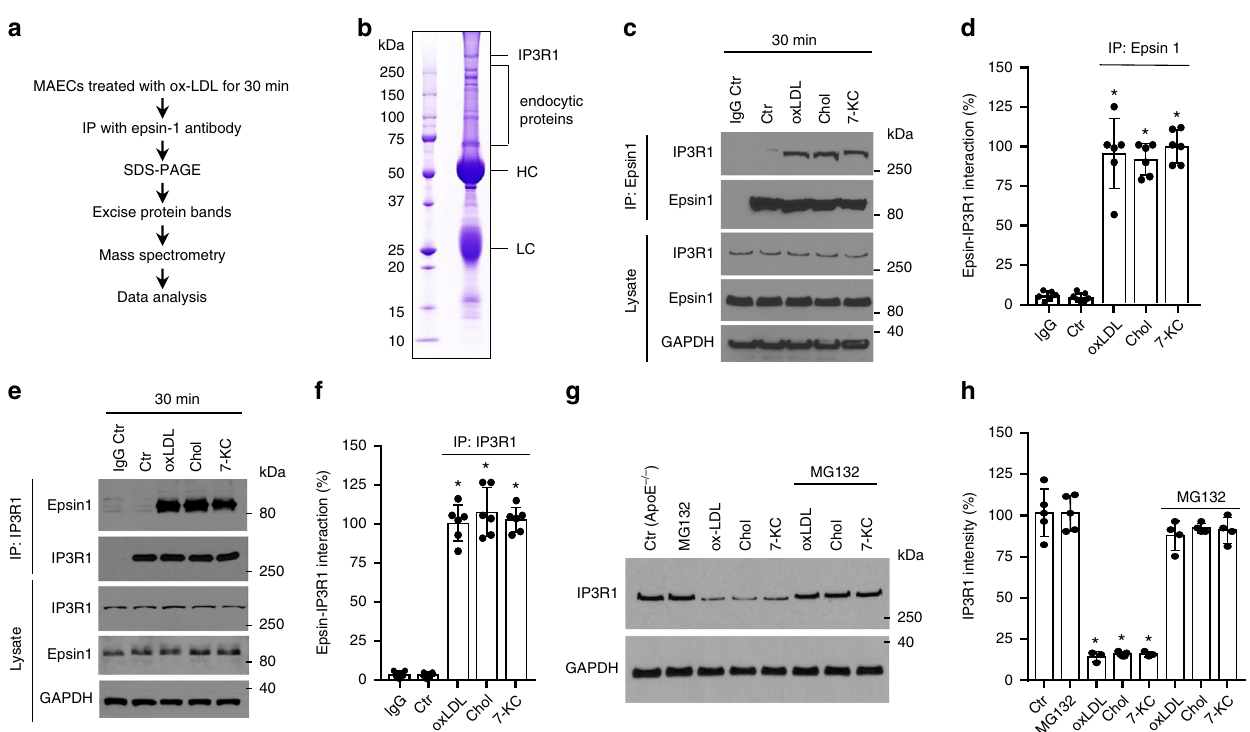
Fig. 1 IP3R1 interacts with epsin 1 in endothelial cells treated with atherogenic cholesterol. a Strategy for identifying epsin 1 binding proteins. b Coomassie-stained gel of the epsin 1 IP immunocomplex from MAECs. Bands were characterized by mass spectrometry. HC heavy chain, LC light chain. c , d MAECs isolated from WT mice were treated with 100 μ g/mL oxLDL or 500 μ g/mL cholesterol crystal (Chol) or 50 μ M 7-KC for 30 min and an immunoprecipitation (IP) was performed using the epsin 1 antibody. The immunocomplex supernatant was probed with antibodies to IP3R1 or epsin 1 by western blot analysis ( c ) and then quanti fi ed ( d ) ( n = 6 independent experiments, asterisk P < 0.05 compared with control). e , f Reciprocal IP using the IP3R1 antibody in the same samples as described in c and d . A representative western blot ( e ) and quanti fi cation ( f ) ( n = 6 independent experiments, asterisk P < 0.05 compared to control) of the IP are shown. g , h MAECs isolated from control mouse aortas (i.e., from ApoE − / − mice) were pre-treated with 5 μ M MG132 for 4 h followed by treatment with 100 μ g/mL oxLDL or 500 μ g/mL Chol or 50 μ M 7-KC for 36 h in the presence of vehicle (DMSO) or MG132. IP3R1 was measured by western blot ( g ) and quanti fi ed ( h ) ( n = 5 independent repeats, asterisk P < 0.001 compared to control). All data were assessed using Student ’ s t-test and are presented as the mean ±